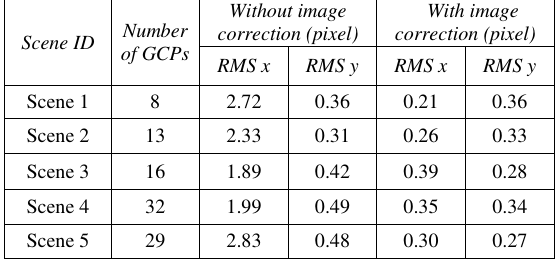
Table 2. Image space residuals obtained in georeferencing of THEOS imagery with and without IO correction.